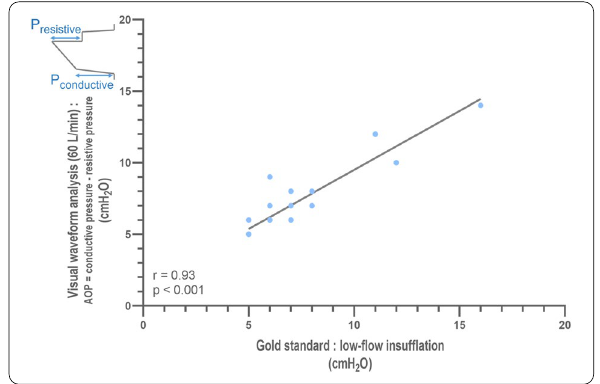
Figure 1: Spearman correlation between AOP obtained by visual wave- form analysis during standard ventilation at 60 L/min and gold standard at low-flow insufflation (full line: linear regression